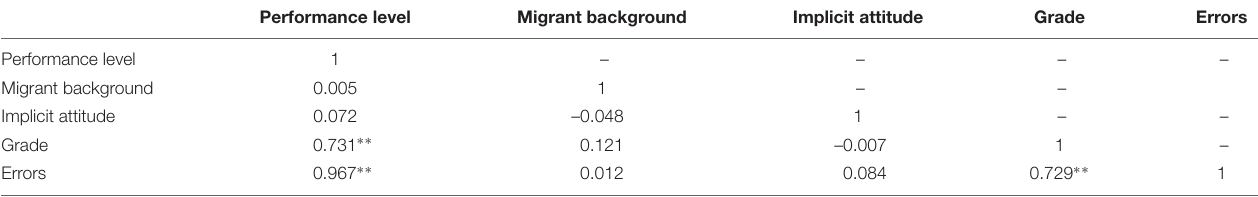
TABLE 2 | Pearson correlation coefficients of all variables.